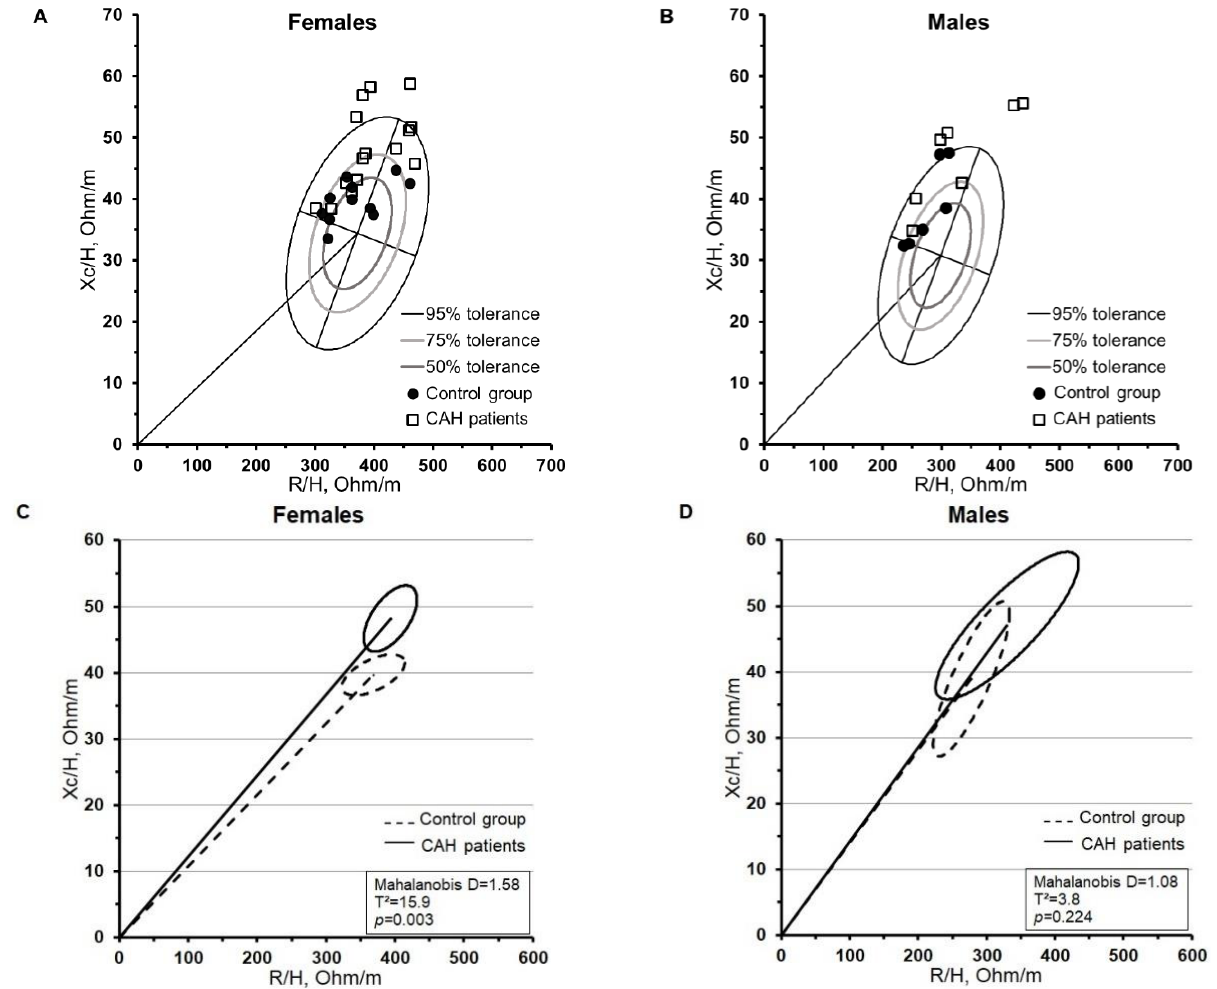
Figure 2. Vector analysis for the comparison of study participants (CAH21OHD group and control group) in female ( A ) and male ( B ) tolerance ellipses and confidence ellipses in females ( C ) and males ( D ).